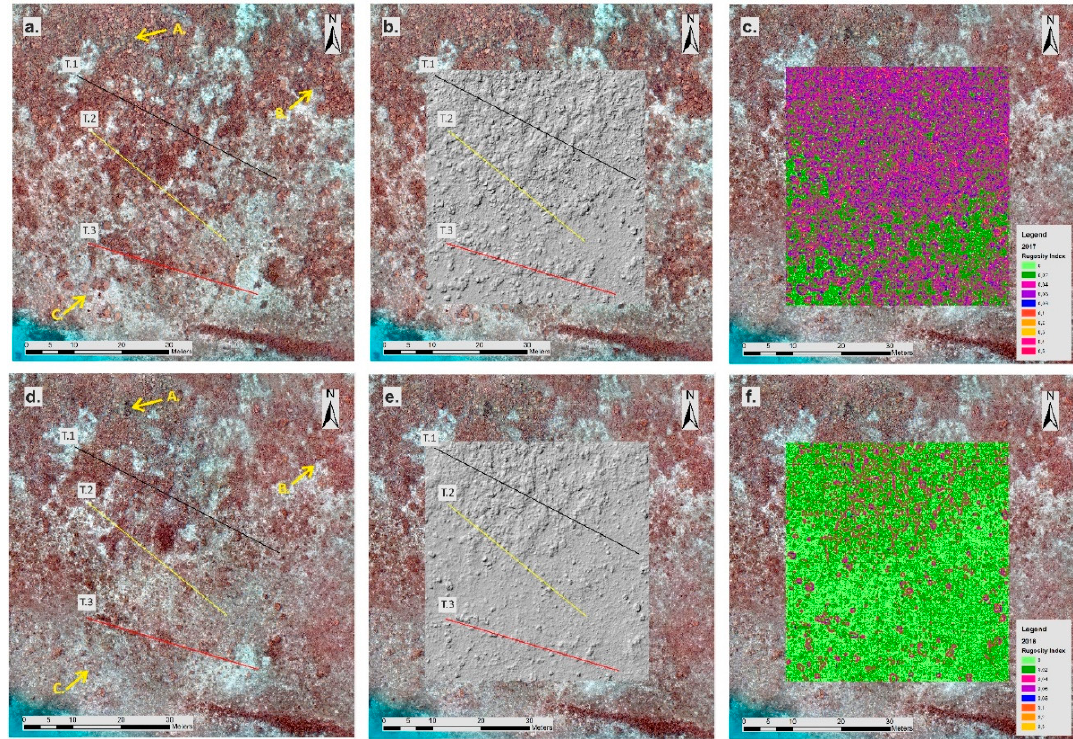
Figure 6. A portion of orthomosaic and DTM of Area 4 monitored in February 2017 ( a – c ) and November 2018 ( d – f ). Hillshade DTM comparison ( b–e ) highlights an overall flattening of the area due to the destruction of coral colonies, mainly Acropora table colonies, indicated by the yellow arrows (for a close-range view, see Figure 11. Colored lines in ( a – d ) and ( b – e ) represent selected transects in which linear rugosity and average slope have been computed (see the text for an explanation and Table 3). ( c,f ) Images representing the rugosity maps of the area around transects.